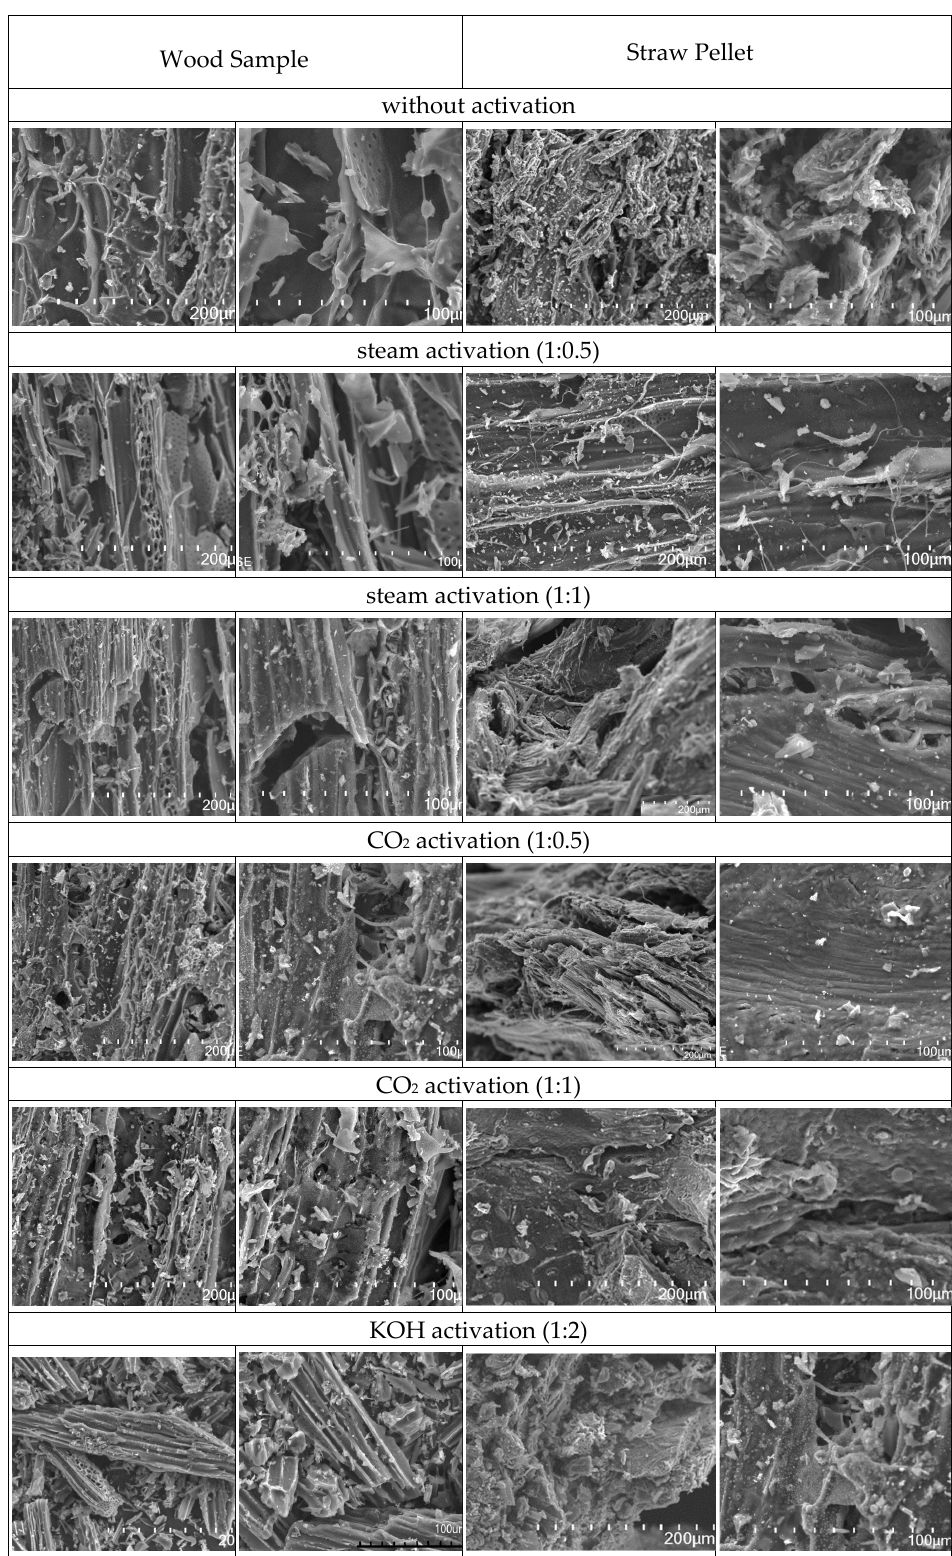
Figure 4. Scanning electron microscopy (SEM) micrographs presenting comparison of wood and straw samples after di ff erent activation methods. The molar ratio of biochar to the activating gas or mass ratio of biochar to KOH are shown in